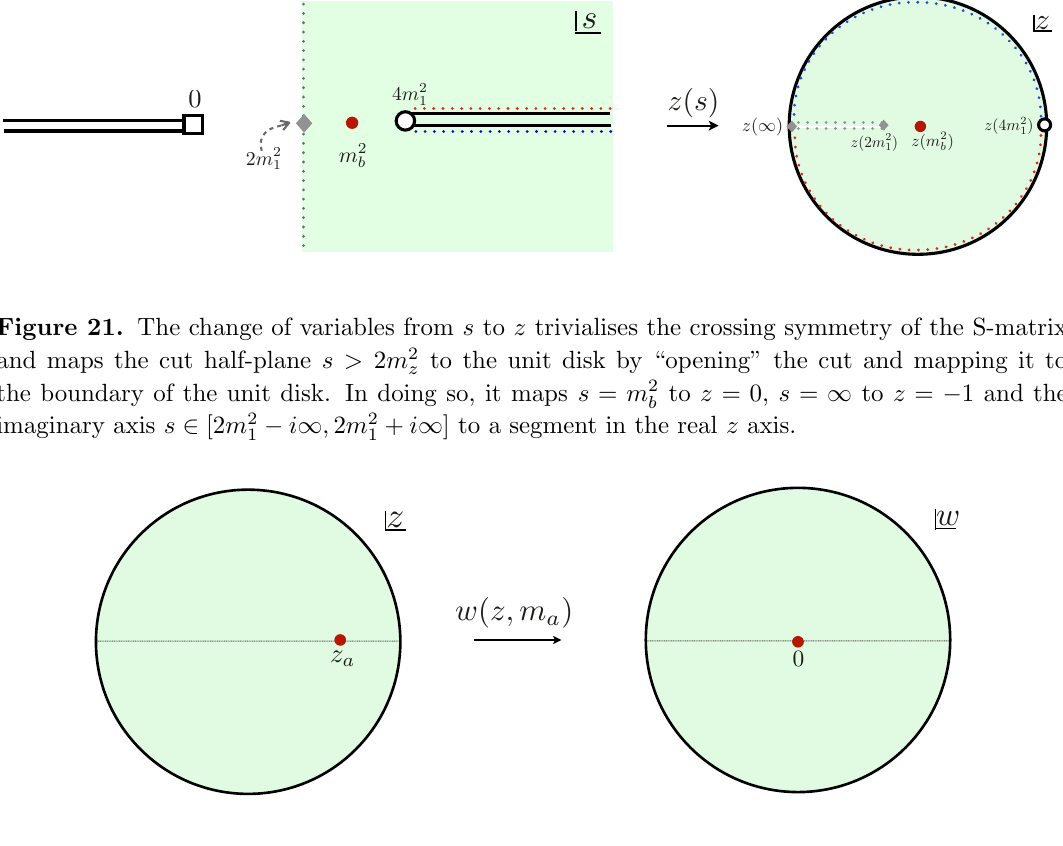
Figure 22. The map w a is an automorphism of the unit disk. It maps z a to the origin. When z a is real, it preserves the real segment [ 1 ; (cid:0)